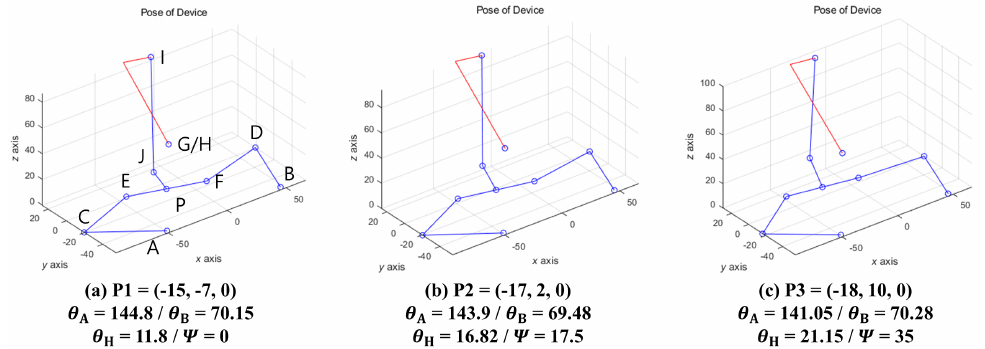
Figure 25. The simulation results of the planned trajectories of the above-mentioned experiment.